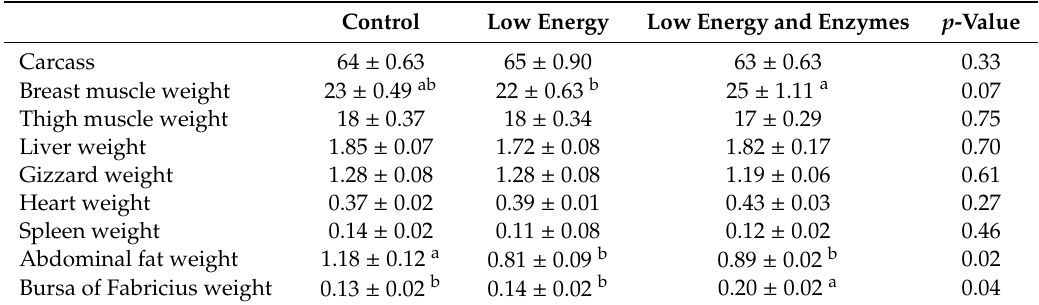
Table 3. E ff ect of NSP enzyme supplementation on organ weights (g / 100 g BW) in